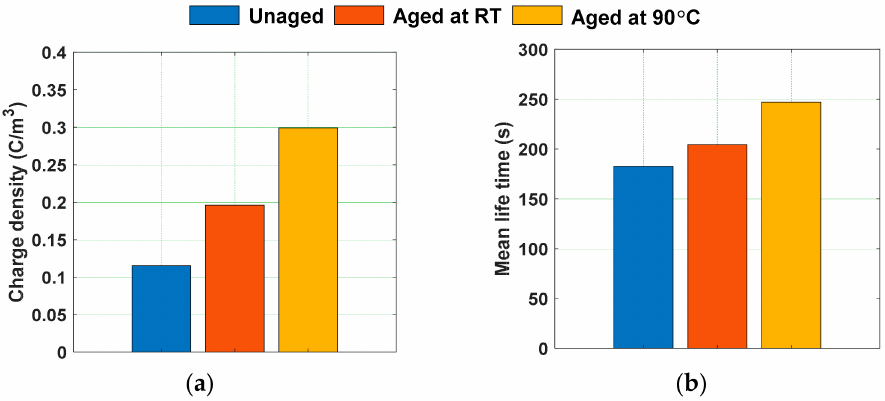
Figure 17. ( a ) Initial charge density just before depoling and ( b ) mean lifetime of space charge decay of water aged samples [30]. Table 4. Modelling parameters of magnitude of charge density during depoling time [30].